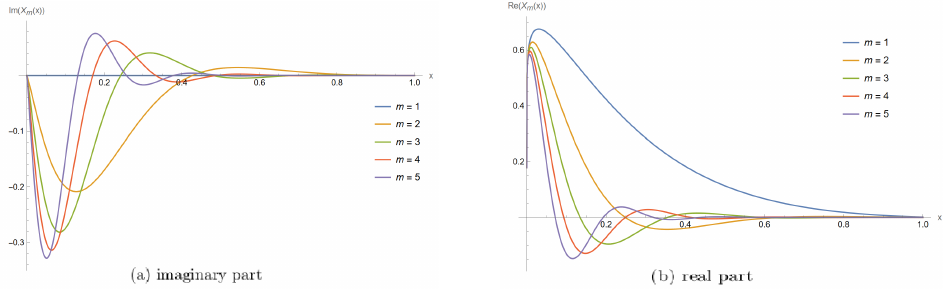
Figure 1. The imaginary and real parts of egenfunctions { P m ( ρ ) } 5